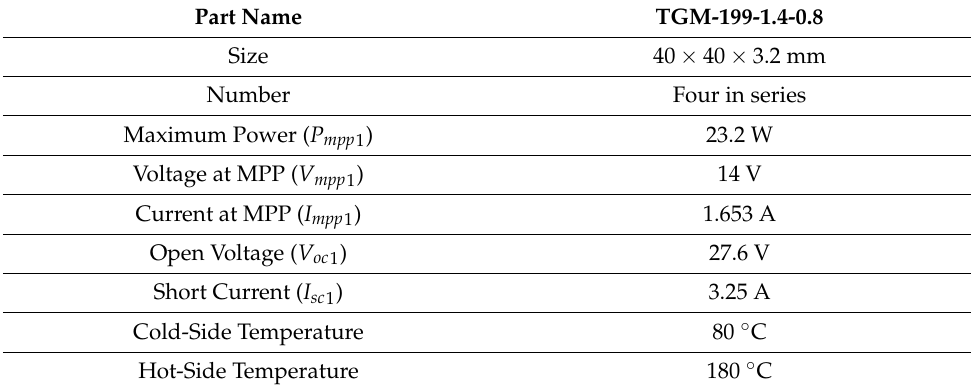
Table 1. Specifications for the first thermoelectric